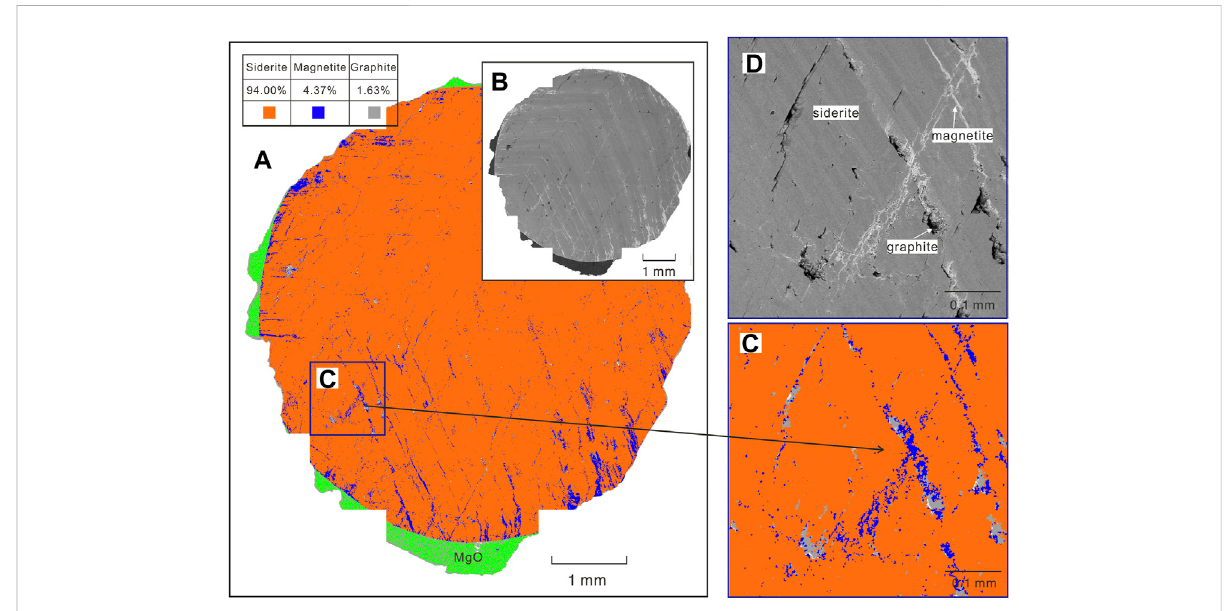
FIGURE 4 A representative mineral mapping of the plane of the cross-section of the recovered sample after conductivity measurement at 1 GPa by TIMA analysis. (A) TIMAmineralphasesmapandsimultaneouslyacquiredBSEimage (B) ofthewholecross-sectionofthesample.Themineralmap (C) and corresponding BSE image (D) of the zoomed area selected from (A) . The dark voids shown in BSE images (D) are the evidence of the release of volatiles and indicate precipitation of graphite. The volume fraction of each mineral was summerized Table 1 acquired from TIMA analysis. The green region shown in (A) represents the MgO sample chamber, as detailed in the experimental assembly diagram.